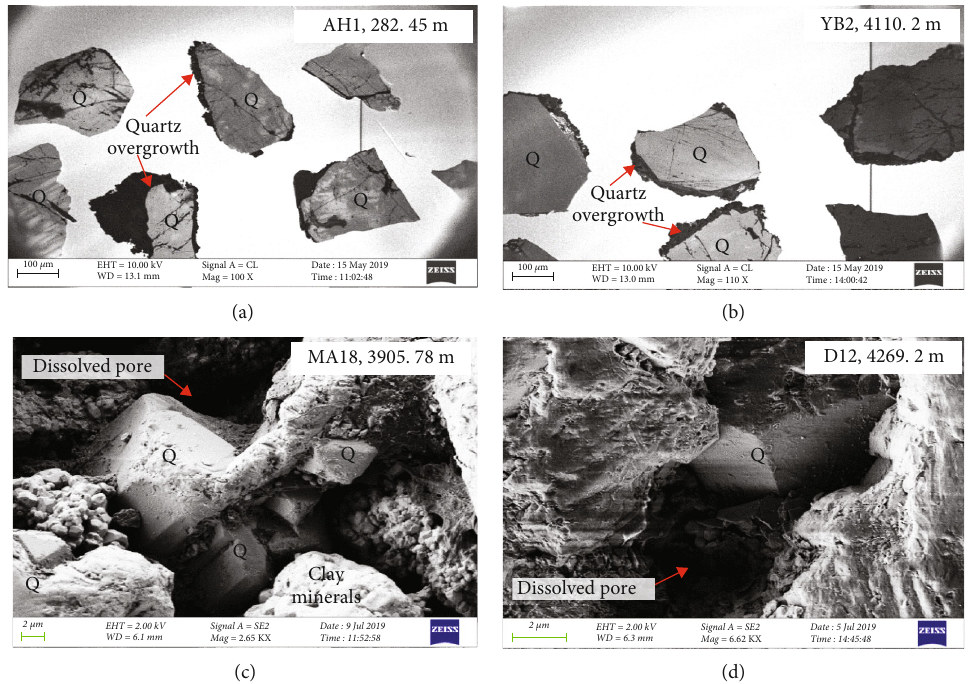
Figure 3: Core and rim features of quartz in cathodoluminescence (upper) and scanning electron microscopy (lower)